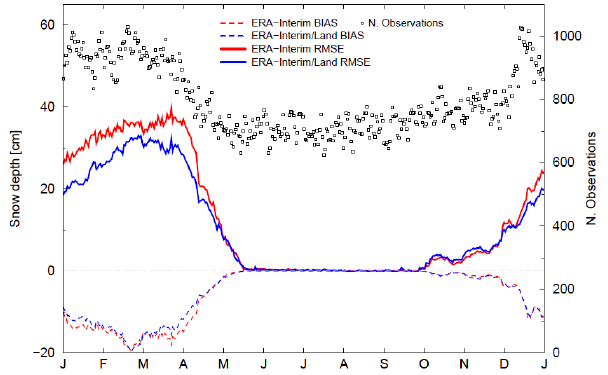
Figure 13. ERA-Interim snow depth RMSE/BIAS (solid/dashed red line) and ERA-Interim/Land snow depth RMSE/BIAS (solid/dashed blue line) with respect to the daily European SYNOP observations at 06:00UTC. The number of stations with snow is in- dicated by squares (right y axis). Model snow depth combines the snow mass and density